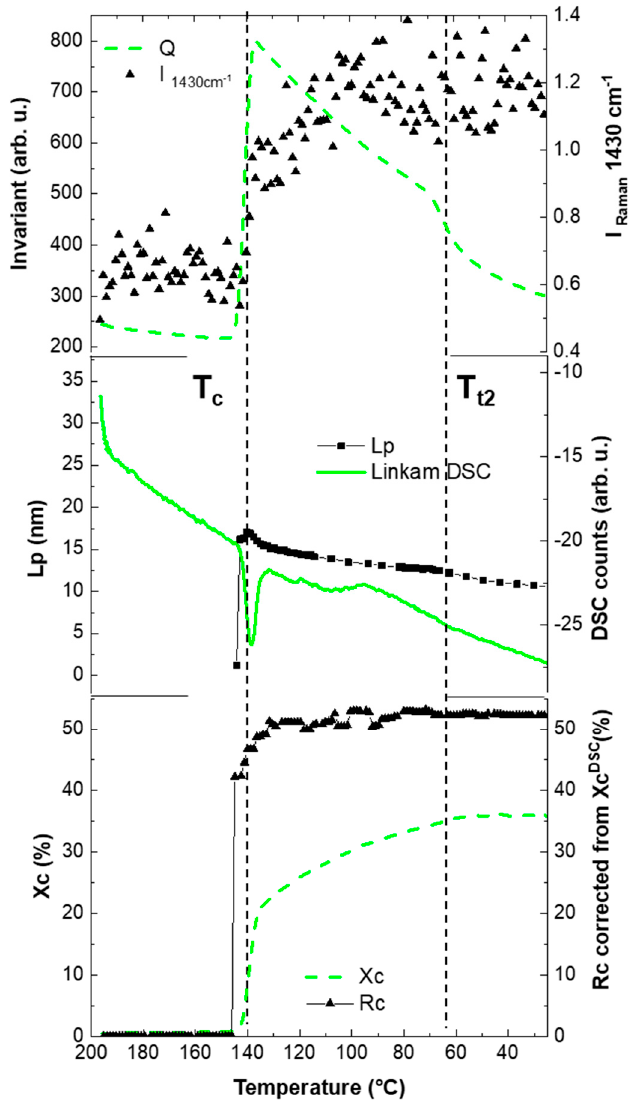
Figure 6. Porod invariant (Q), crystallinity (X c ) and long period (L p ) evolution as a function of temperature during crystallization from the melt (200 °C) of PVDF derivative. The dashed line ( ≈ 145 °C) indicates the onset of crystallization transition (T c ) and the dashed line ( ≈ 65 °C) the transition of the secondary crystallization/rigid amorphous compaction (T t2 ).